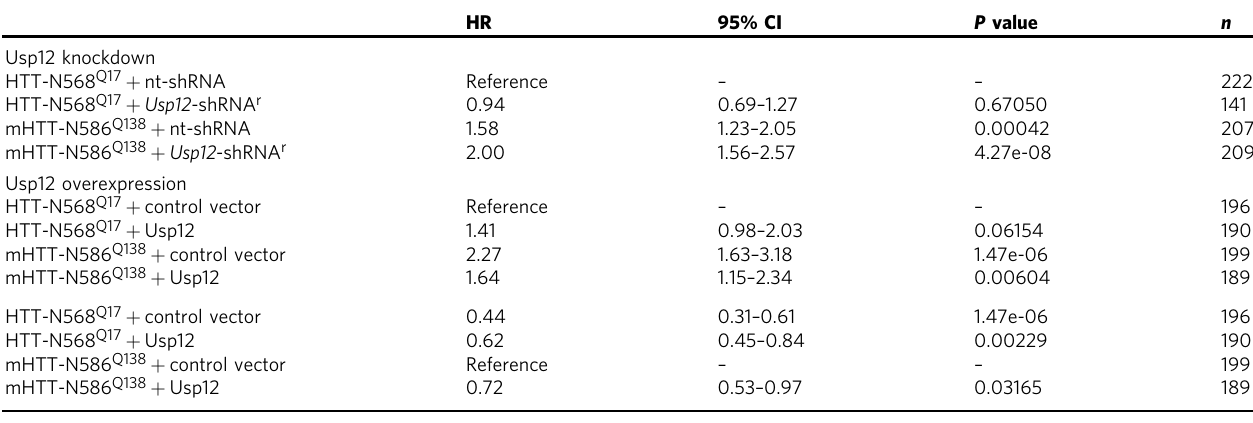
Table 1 Cox proportional hazards analysis of the effects of Usp12 knockdown or overexpression on survival of rodent primary neurons